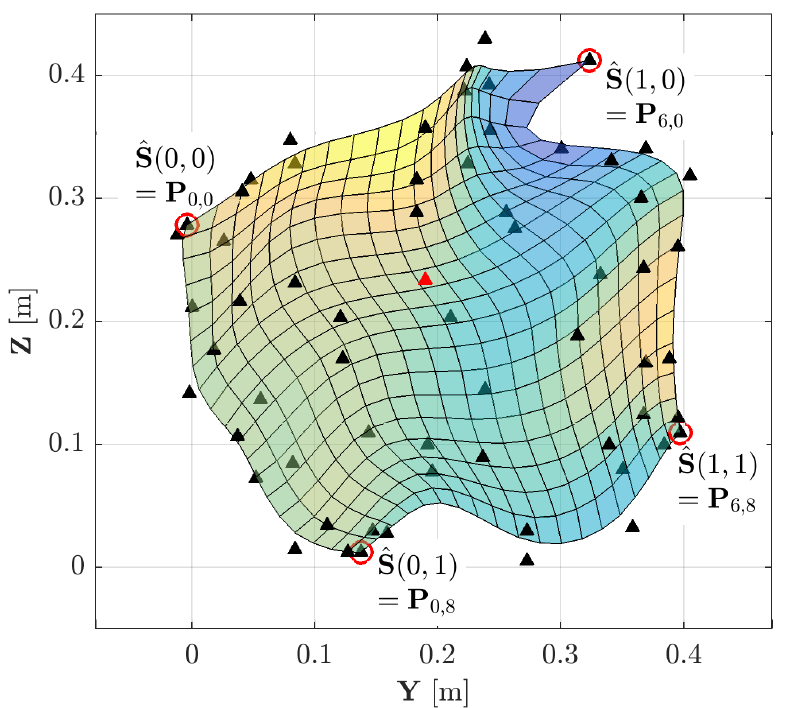
Figure 7. Reference surface and corresponding control points (triangles) used for the data simulation [30]. Red triangle: control point P 3,3 . The X -axis complements the right-handed co- ordinate system, and the surface’s colouring gives an idea of its height in the X direction.